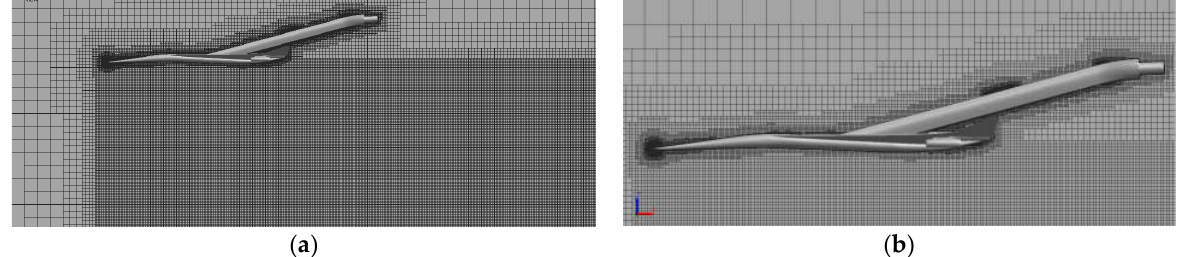
Figure 20. Computational domain (LM1021), ( a ) general view, ( b ) closeup.